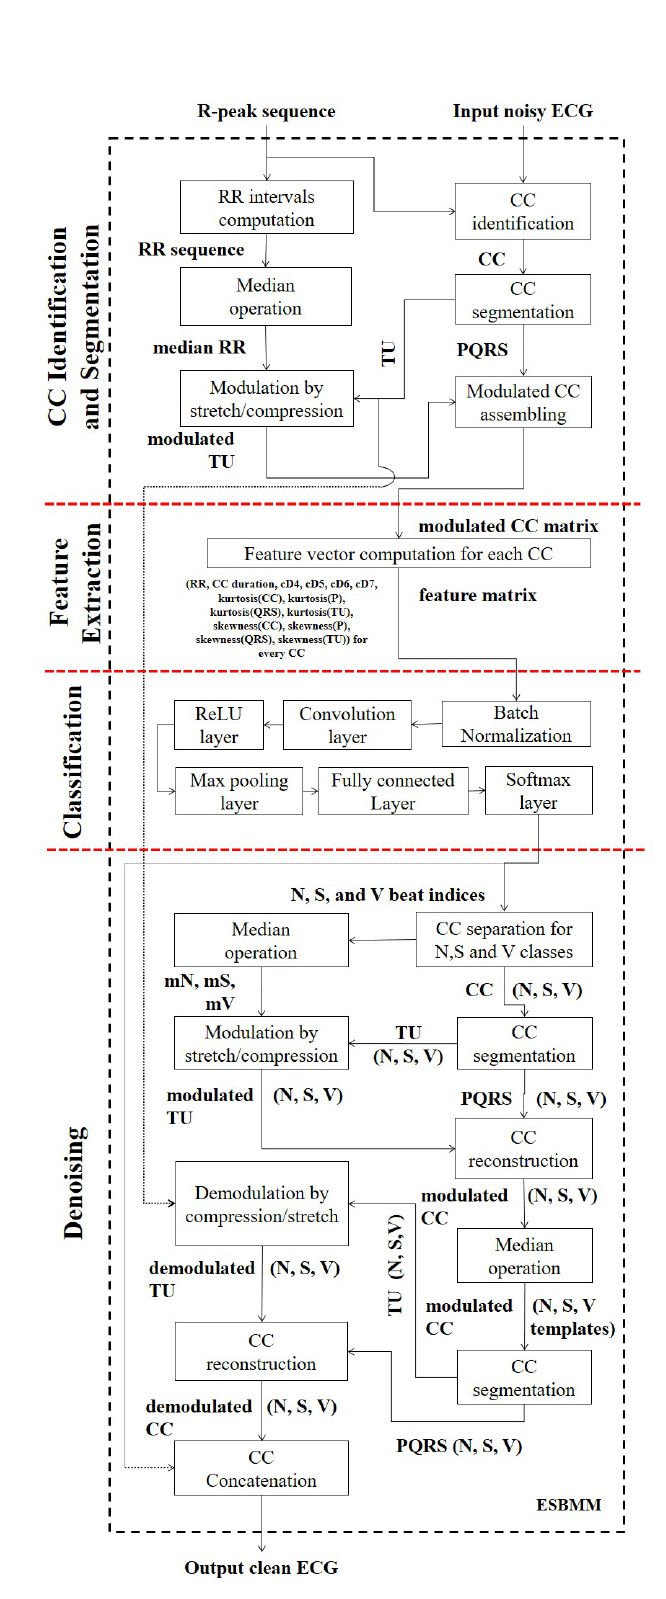
Figure 2. Flow chart of the extended segmented beat modulation method